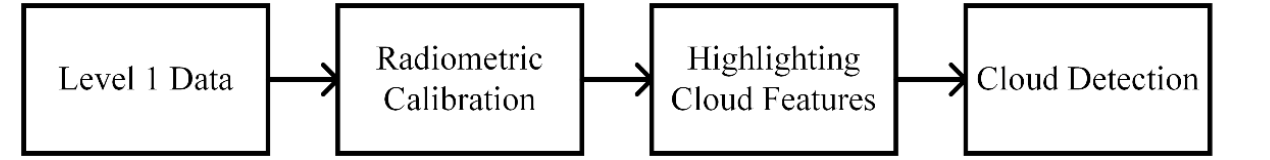
Figure 4. Schematic diagram of the cloud inspection workflow.